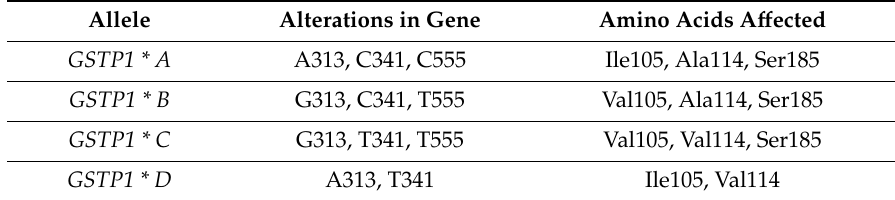
Table 1. Polymorphisms of